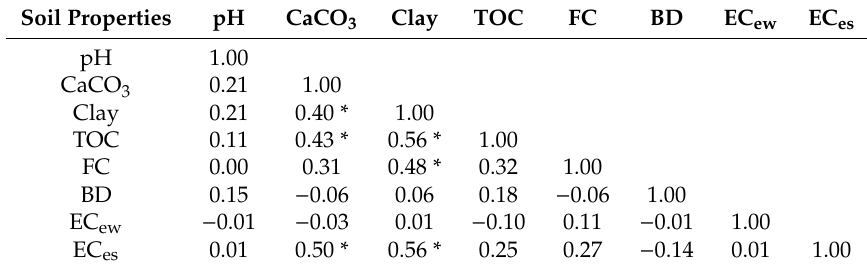
Table 3. Correlation matrix among pH, amounts of carbonates (CaCO 3 ), clay and total organic C (TOC), water content at field capacity (FC), bulk density (BD) and electrical conductivity in the non-irrigation winter period (EC ew ) and irrigation summer period (EC es ). * indicates significant Spearman’s rank correlation coe ffi cients ( p < 0.05). CaCO